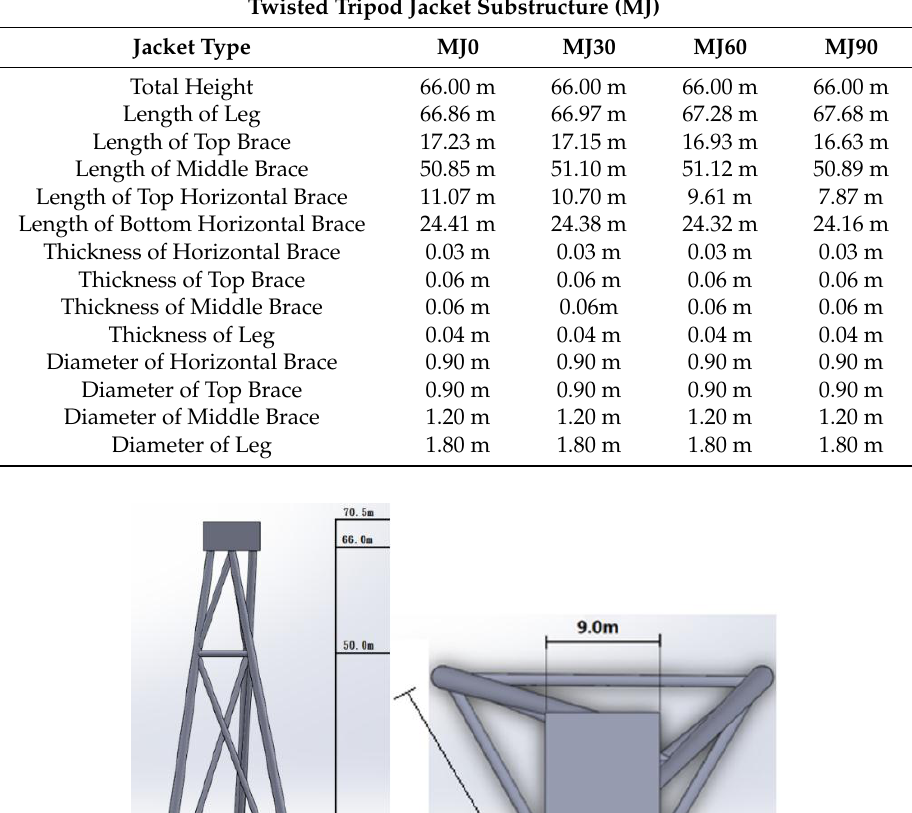
Table A4. Specification of four MJ-structures.